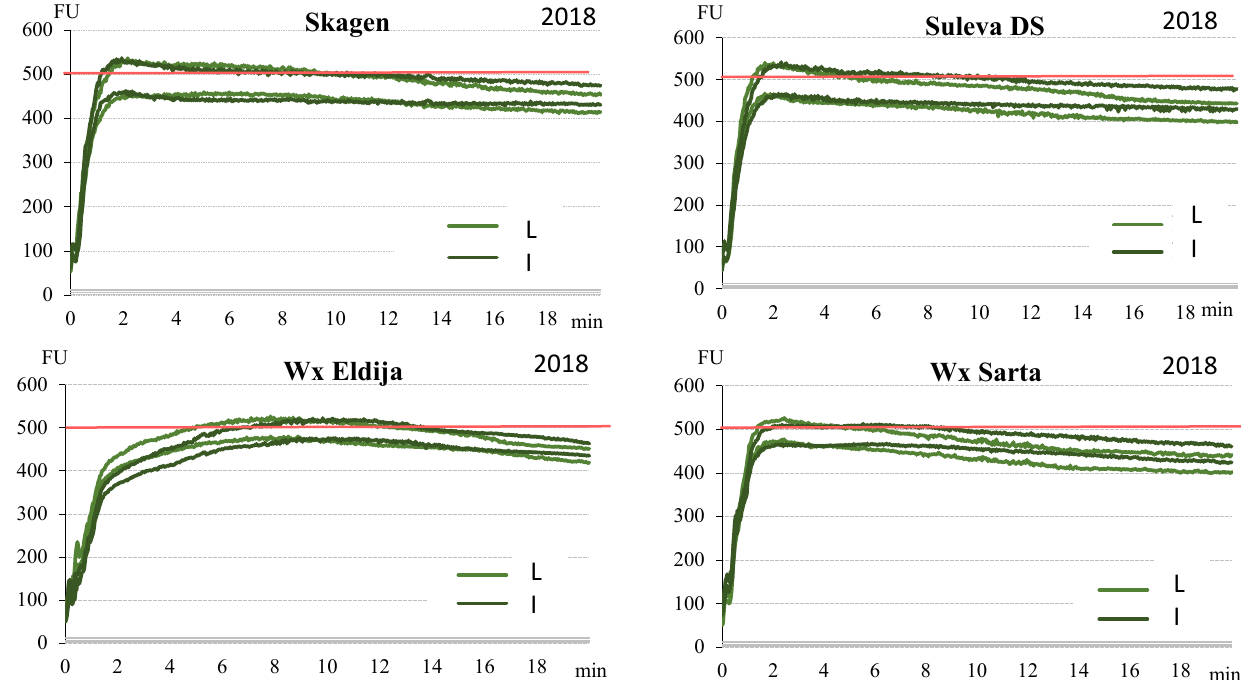
Figure 3. Dough mixing profiles for non-waxy (‘Skagen’, ‘Suleva DS’) and waxy (‘Eldija’, ‘Sarta’) winter wheat cultivars grown under different farming systems (L—low-input, I—intensive) in 2018. Analysis performed with Brabender’s farinograph.